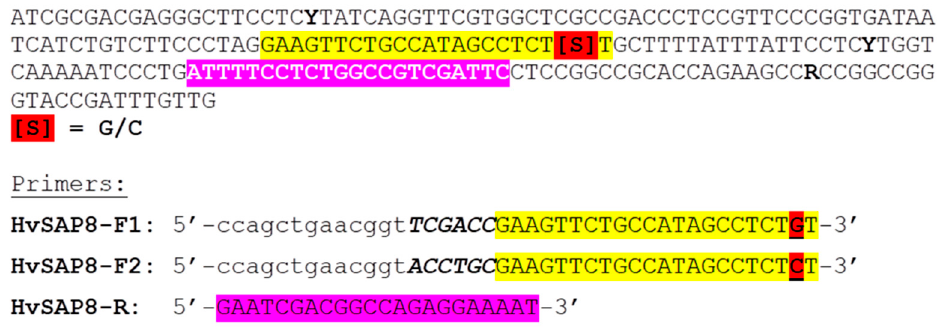
Figure 6. ASQ primer design in the fragment of HvSAP8 gene promoter sequence in barley parents, Granal and Baisheshek. The targeted SNP is designated by red and other SNP are shown by degen- erative nucleotides in the sequence in Bold. Two Forward allele-specific primers (F1 and F2) have a common part indicated in yellow but differ by nucleotides at the SNP position underlined and high- lighted in red. At the 5 ′ -end, the 13-bp fragment is common and indicated in lower case letters, while the 6-bp fragment in the middle of both Forward primers is a specific ‘tag’ shown in Bold-Italic case. The common reverse primer is highlighted in pink, with ‘reverse-complement’ order indicated by black and white fonts of letters in Reverse primer and in the sequence, respectively.